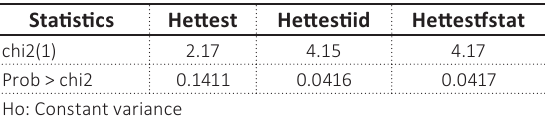
Table 3. Breusch-Pagan/Cook-Weisberg test for heteroscedasticity